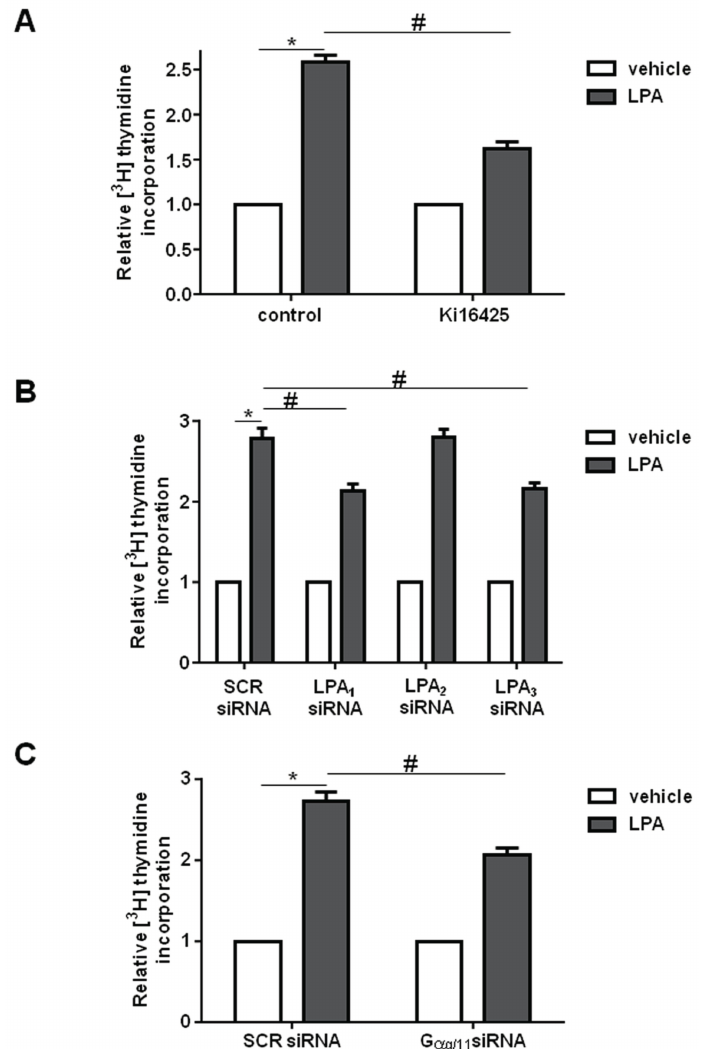
Figure 7. LPA-induced proliferation relies on LPA 1 /LPA 3 and G α q/11 engagement. Serum-starved C2C12 myoblasts were pre-incubated for 30 min: in the presence or absence of 2.5 µ M Ki16425 ( A ); transfected with scrambled (SCR-) or with specific siRNA for individual LPA receptors ( B ); or transfected with SCR- or G α q/11-siRNA ( C ) before being stimulated with 100 nM LPA for 16 h. [ 3 H]Thymidine (0.5 µ Ci/well) was added during the last hour of incubation. Data are mean ± SEM of at least three independent experiments performed in triplicate. [ 3 H]Thymidine incorporation in untreated control cells was 14,820.5 ± 891.36 dpm, in Ki16425 treated cells was 8959 ± 512 dpm, in SCR-siRNA transfected cells was 54,265.67 ± 2870.51 dpm, LPA 1 -siRNA transfected cells was 40,903 ± 4714.41 dpm, LPA 2 -siRNA transfected cells was 63,503 ± 5802.95 dpm, LPA 3 -siRNA transfected cells was 41,470.33 ± 5792.39 dpm, in SCR-siRNA transfected control cells was 7398 ± 14 dpm, and in Gaq/11 siRNA transfected cells was 1854.33 ± 487.28 dpm. The mitogenic effect of LPA was statistically significant by Student’s t test (* p < 0.05). The effect of LPA 1/3 inhibition by Ki16425 ( A ); the effect of down-regulation of LPA 1 or LPA 3 ( B ); or the effect of down-regulation of G α q/11 ( C ) was statistically significant by two-way ANOVA followed by Bonferroni’s post hoc test ( # p <